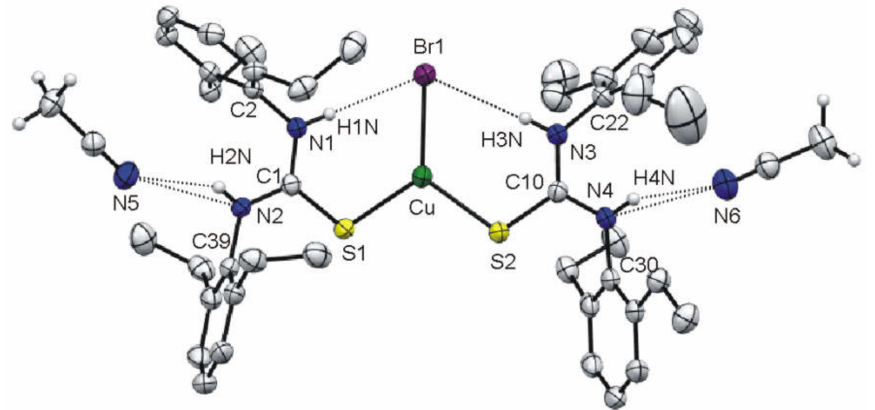
Figure 4. Molecular structure of 1b (ellipsoids correspond to the 50% probability level). All hydro- gen atoms, except those of N-H and CH 3 hydrogens of acetonitrile, have been deleted for clarity. Selected bond lengths (Å) and angles ( ◦ ): Br1–Cu1 2.3721(4), Cu1–S1 2.2143(7), Cu1–S2